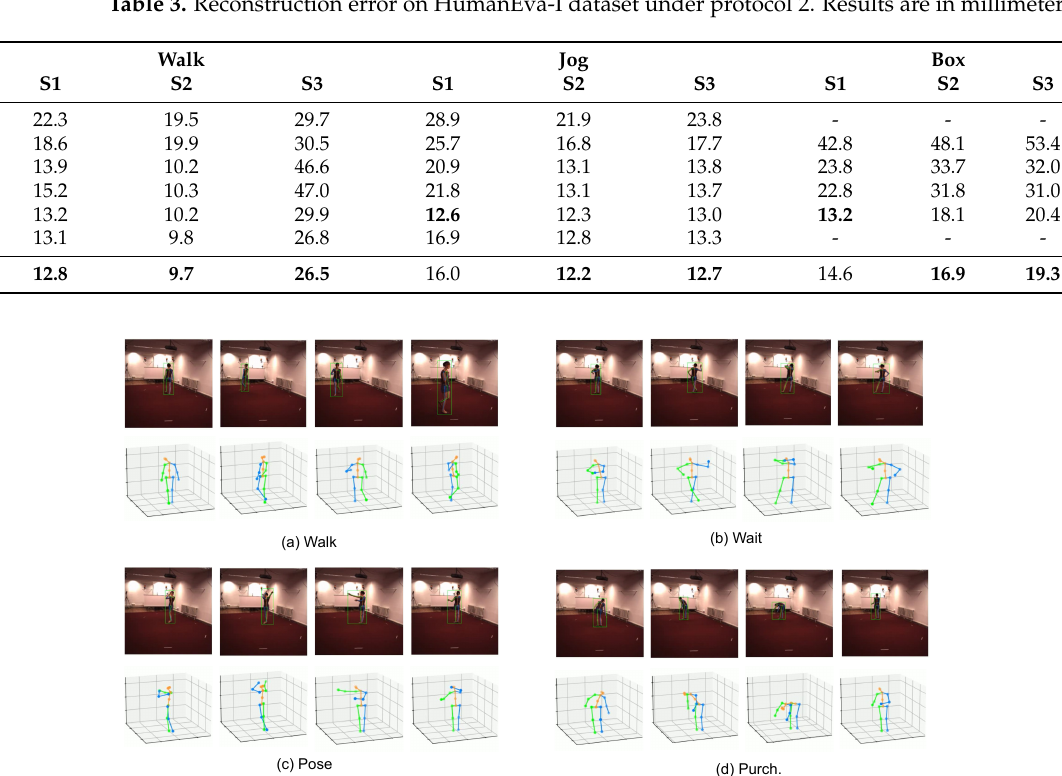
Table 3. Reconstruction error on HumanEva-I dataset under protocol 2. Results are in millimeters.